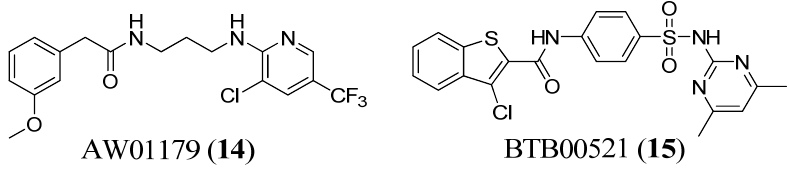
Figure 6. Structures of AW01179 and BTB00521.